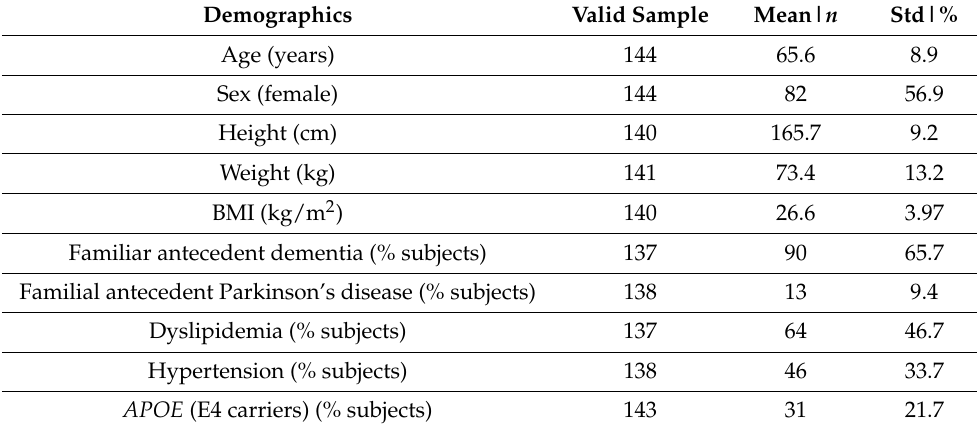
Table 4. Demographics of the selected